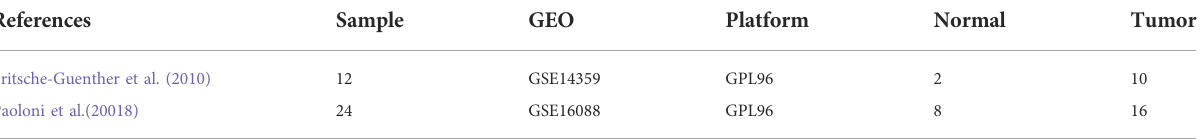
TABLE 1 Details for GEO Osteosarcoma